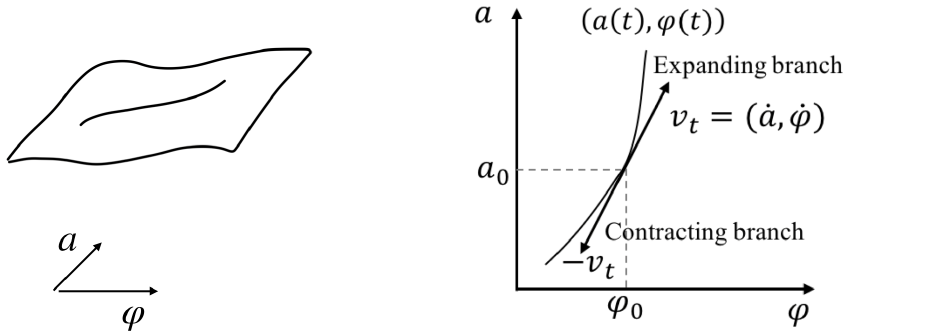
Figure 15. ( Left ): the evolution of the universe can be seen as a trajectory in the minisuperspace. ( Right ): a trajectory in the minisuperspace that is positively oriented with respect to the scale factor component describes an expanding universe. Similarly, a negatively oriented trajectory describes a contracting